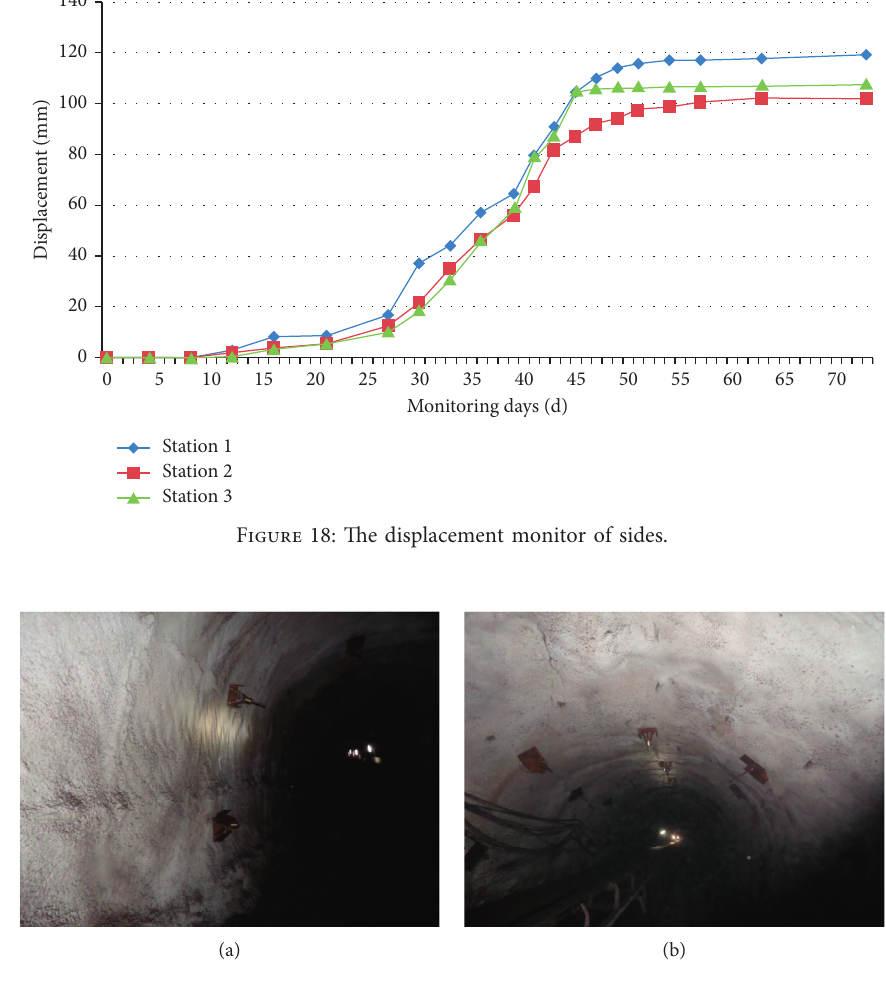
Figure 19: Support